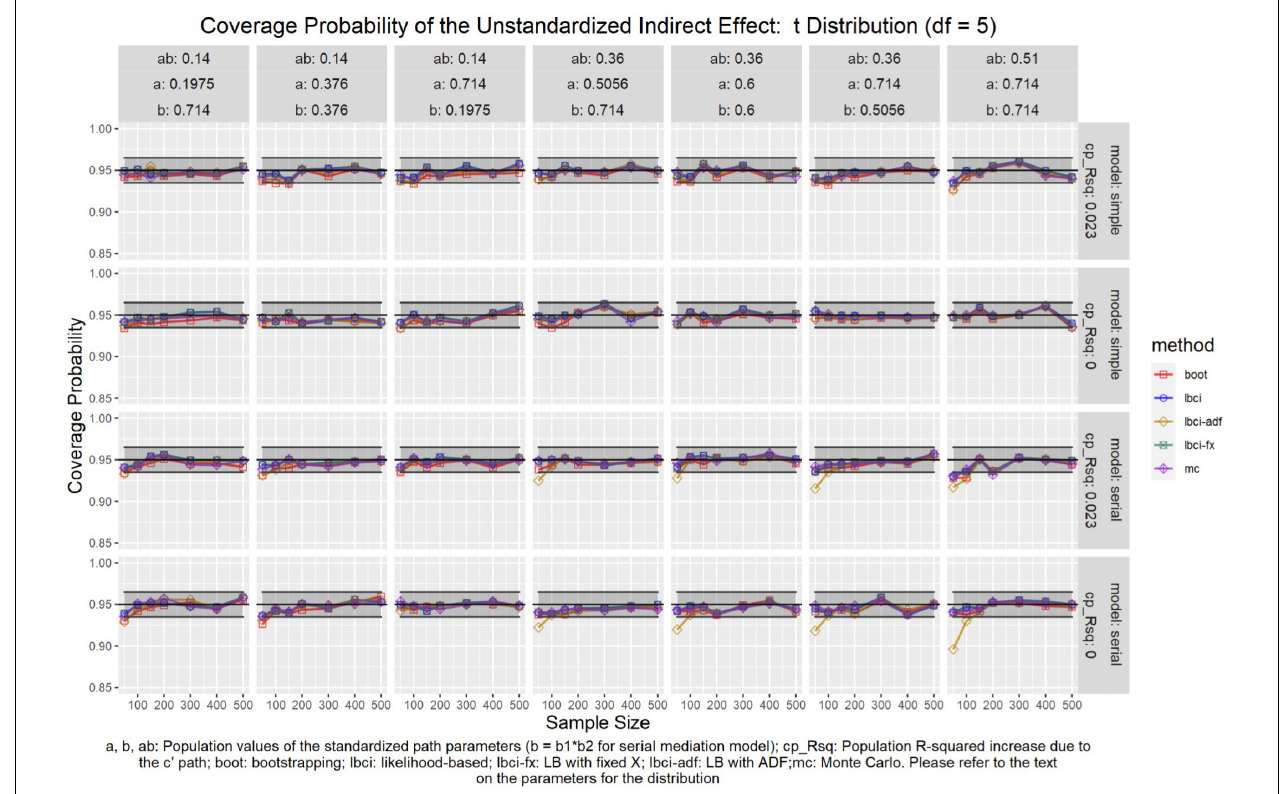
FIGURE 7 | t (5) Distribution (Unstandardized Indirect Effect). a, b, ab: Population values of the standardized path parameters (b = b1 × b2 for serial mediation model); cp_Rsq: Population R-squared increase due to the c (cid:48) path; boot: bootstrapping; Ibci: likelihood-based; Ibci-fx: LB with fixed X; Ibci-adf: LB with ADF;mc: Monte Carlo. Please refer to the text on the parameters for the